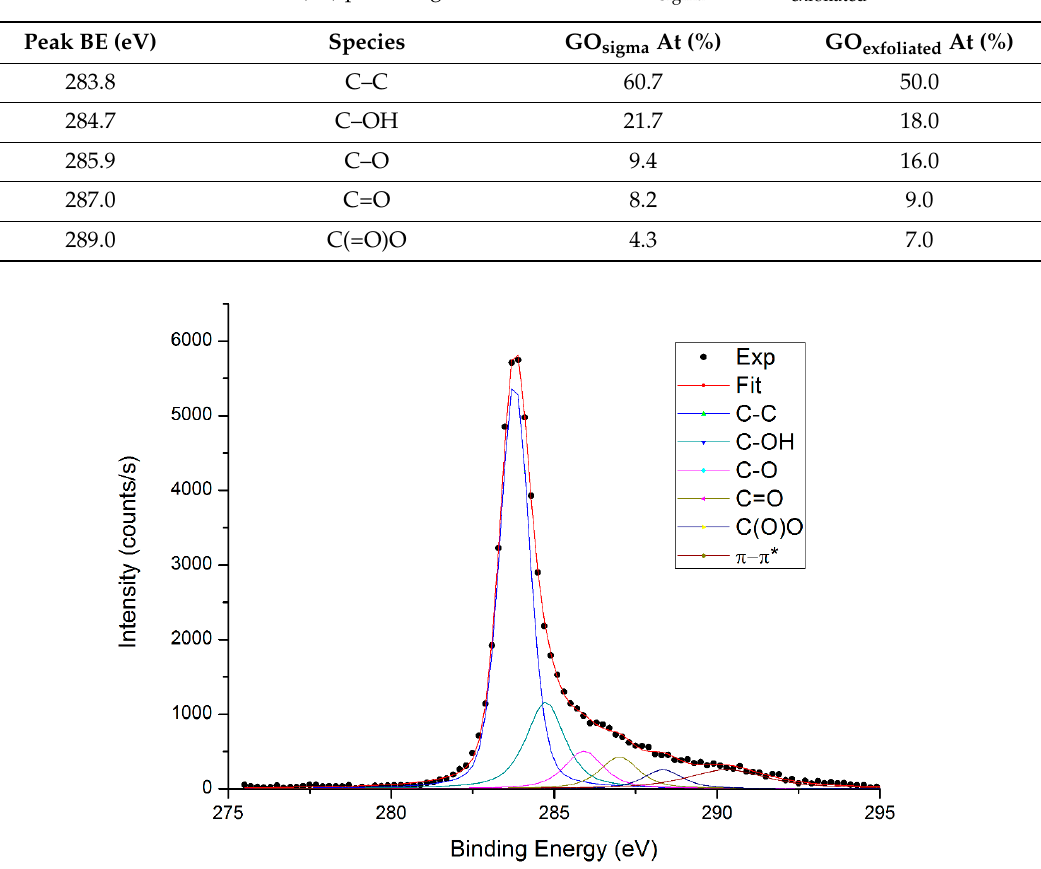
Table 1. Raman parameters for GO sigma and GO exfoliated.